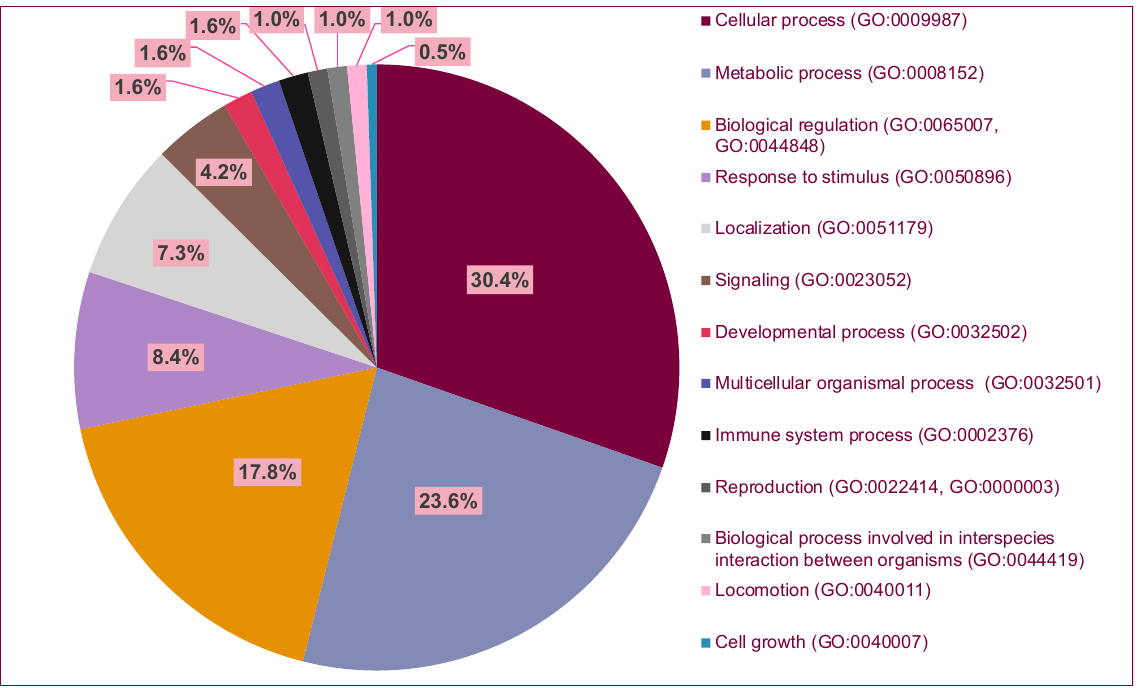
Figure 2. The biological role of the genes under positive natural selection. Processes in the legend are listed in descending order by the number of genes involved. Analysis is based on the PANTHER classification system [39] and the Gene Ontology Browser [40].